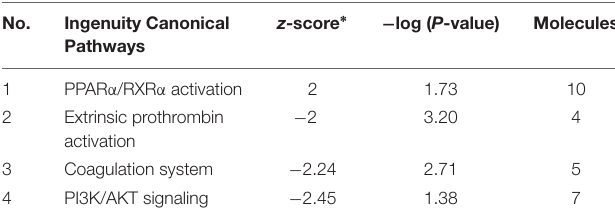
TABLE 1 | Significantly repressed or activated pathways in liver between the two groups on the second week. No.